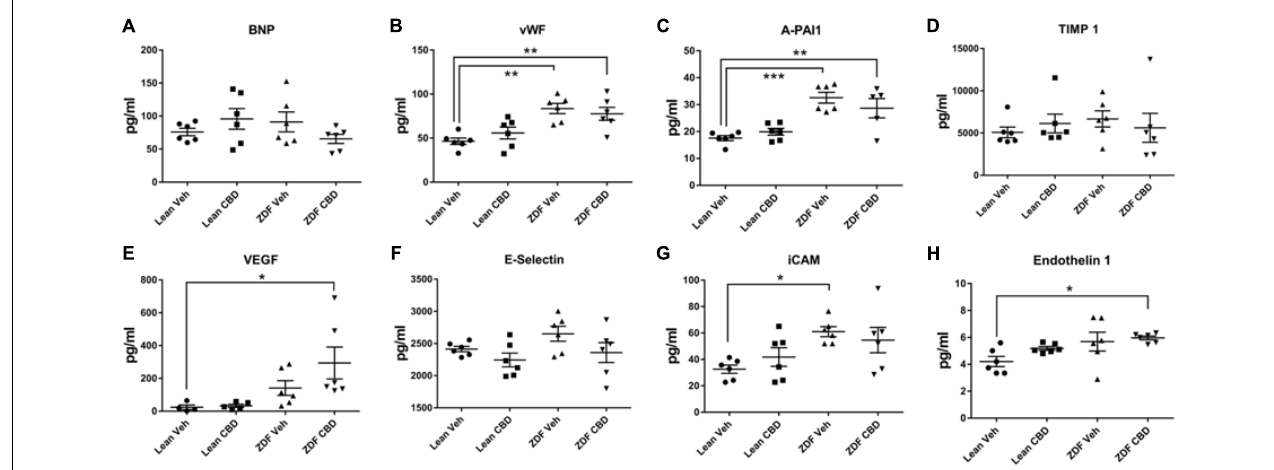
FIGURE 6 | Circulating cardiovascular biomarkers in serum samples from ZDF Lean (circles and squares) and ZDF rats (triangles) treated with either vehicle (circles and upward triangles) or 10 mg/kg CBD (i.p., 7 days; squares and downward triangles). Data are mean ± SEM, with n = 6 animals per group. ∗ P < 0.05. ∗∗ P < 0.01, ∗∗∗ P < 0.001.